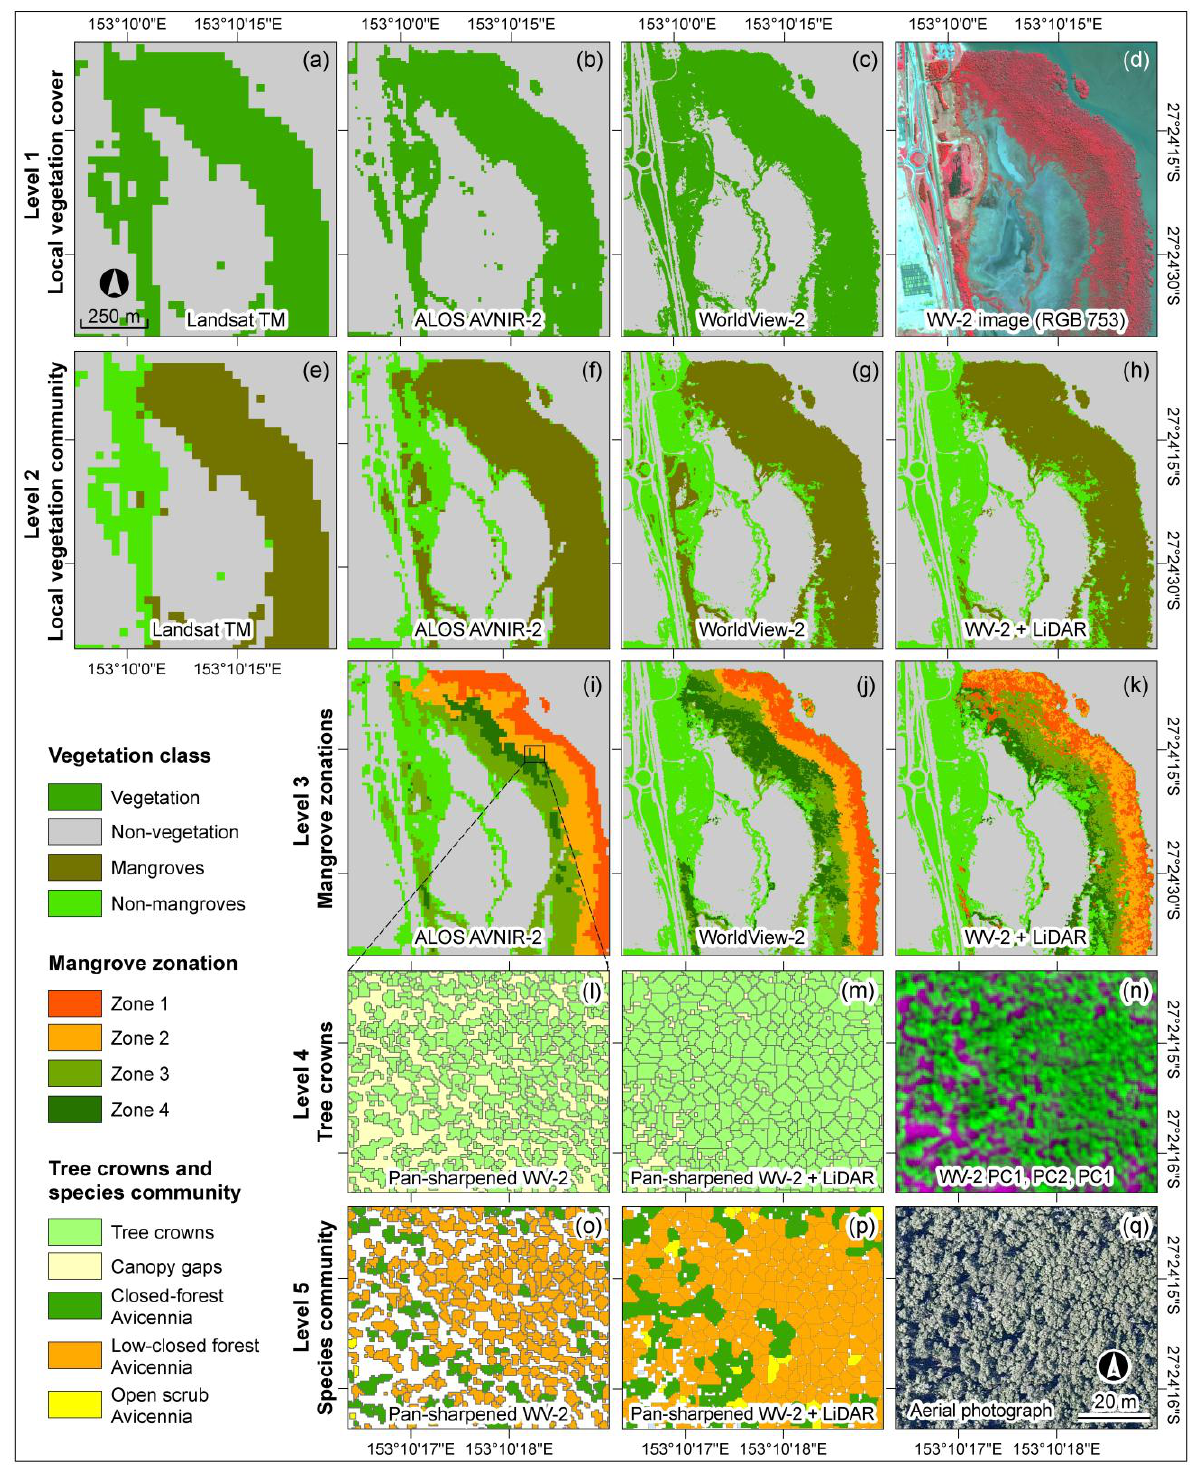
Figure 9. Example subsets of mangrove composition maps at Whyte Island, Moreton Bay, showing all hierarchy levels produced from different image sources: ( a ) level 1 TM, ( b ) level 1 AVNIR-2, ( c ) level 1 WV-2, ( d ) WV-2 image (RGB 753), ( e ) level 2 TM, ( f ) level 2 AVNIR-2, ( g ) level 2 WV-2, ( h ) level 2 WV-2+LiDAR, ( i ) level 3 AVNIR-2, ( j ) level 3 WV-2, ( k ) level 3 WV-2+LiDAR, ( l ) level 4 pan-sharpened WV-2, ( m ) level 4 pan-sharpened WV-2+LiDAR, ( n ) WV-2 PC1,2,1, ( o ) level 5 pan-sharpened WV-2, ( p ) level 5 pan-sharpened WV-2+LiDAR and ( q ) true color aerial